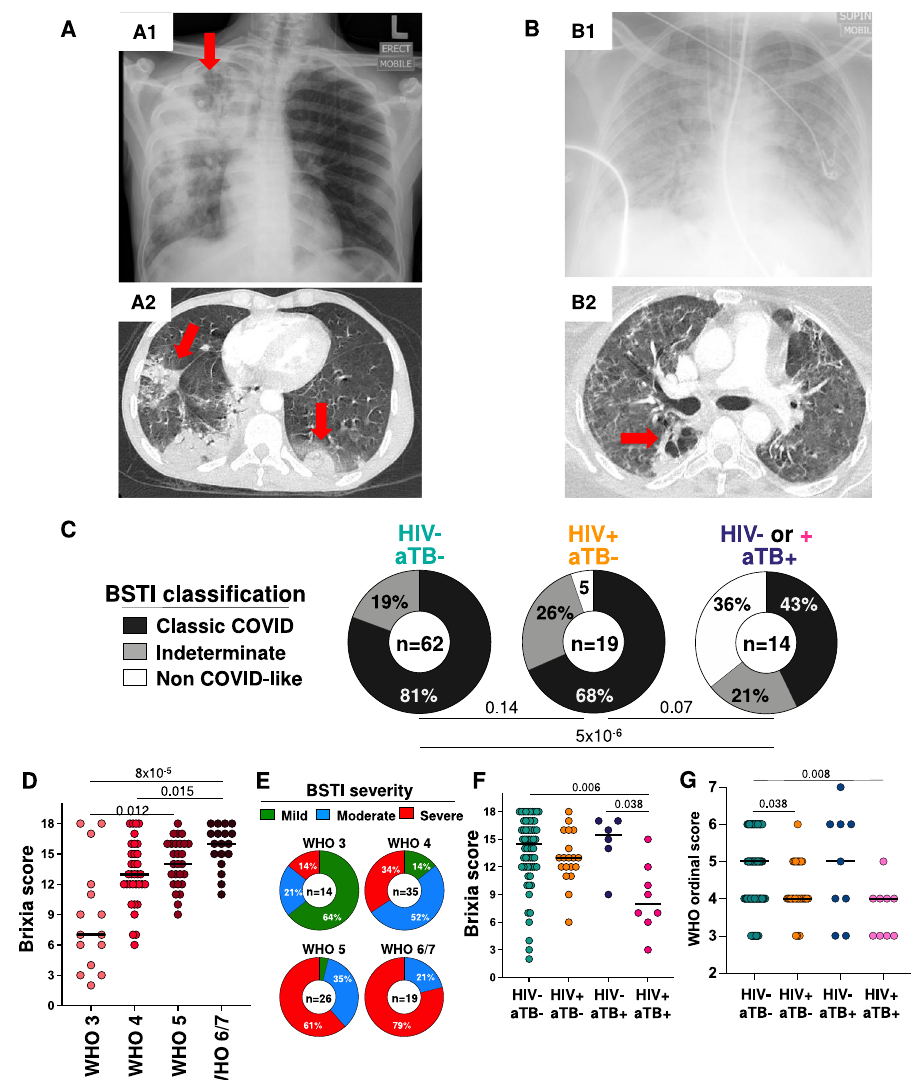
Fig.1|RadiographicappearancesofcombinedSARS-CoV-2and M.tuberculosis infectionandrelationshipbetweenradiographic(BrixiaandBritishSocietyfor Thoracic Imaging (BSTI)) score and clinical severity assessed by WHO COVID- 19 ordinal scale. A, B Chest radiographs and computed tomographic pulmonary angiography (CTPA) of two COVID-19 patients. A1: 43-year-old HIV-1 uninfected male (patient number 58) presenting with consolidationand cavitation in the right upper lobe (red arrow), 3+ sputum smear positive and also SARS-CoV-2 RT-PCR positive(thresholdcycle:32.45).A2:Becauseofpersistenthypoxiaandtachypnoea heunderwentCTPAwhichshowedbi-basalwedge-shapedopacitiesinkeepingwith pulmonary embolism (PE) and/or consolidation related to COVID-19. Discharged after 22 days. B1: 43-year-old HIV-1 uninfected female (patient number 36) pre- senting with SARS-CoV-2 positive RT-PCR (threshold cycle: 21.2) with diffuse bilateralpulmonaryopaci fi